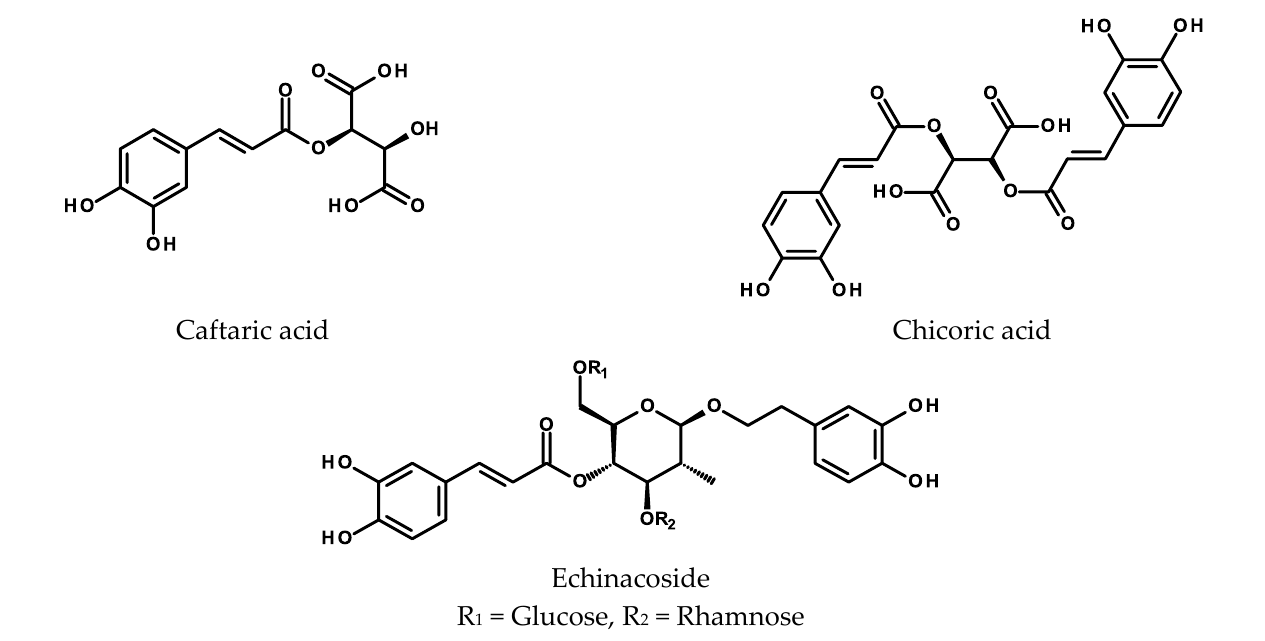
Figure 3. Chemical structures of caftaric acid, chicoric acid, and echinacoside.